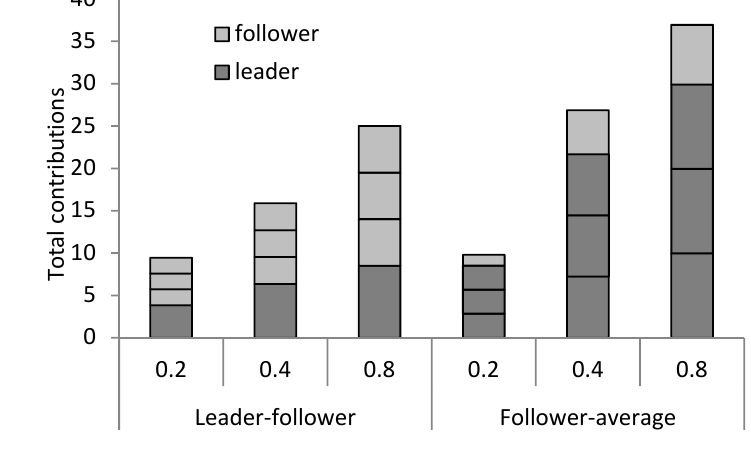
Figure 1. Average total contributions in each of the six games distinguishing the role played by leaders and